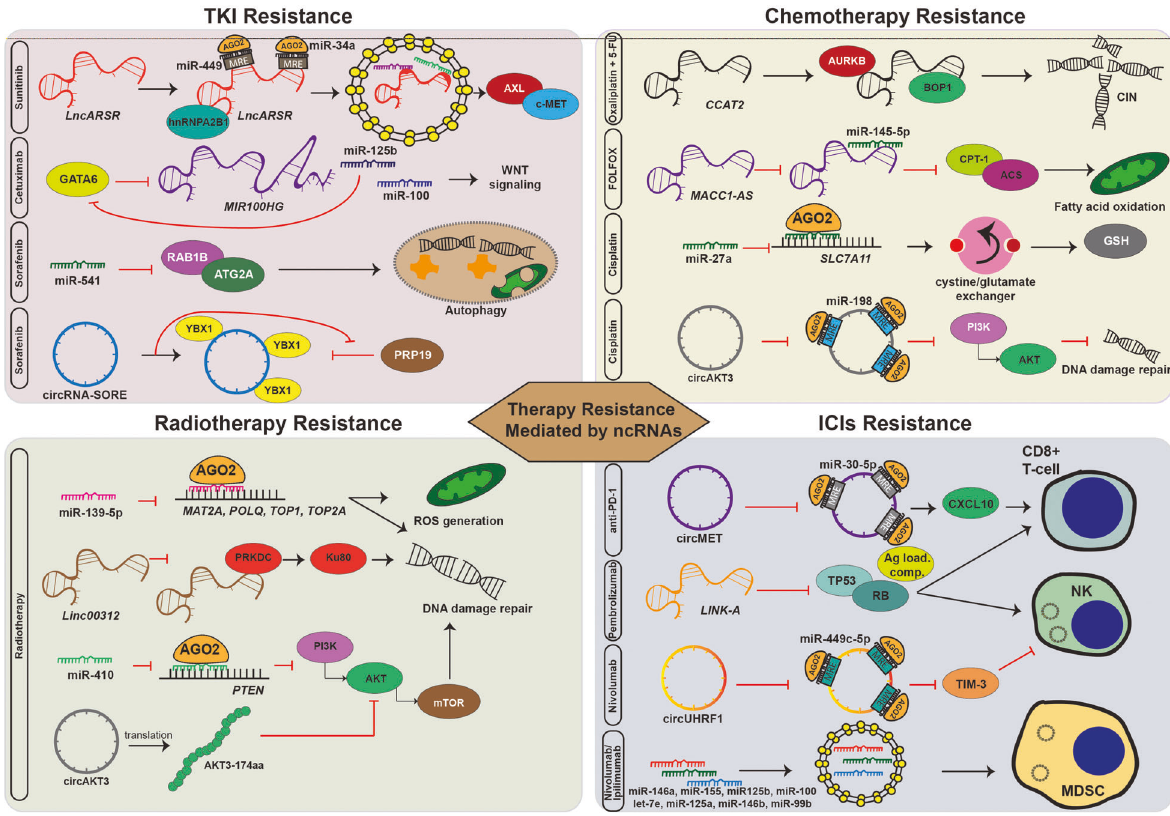
Fig. 2 Mechanisms of therapy resistance mediated by ncRNAs. Examples of the common mechanisms of cancer cell resistance to tyrosine kinase inhibitors, chemotherapy, radiation, and immune checkpoint inhibitors mediated by miRNAs, lncRNAs, or circRNAs. The common mechanisms include (1) modulation of defending intrinsic pathways against the xenobiotics, e.g., miR-27a directly binds to SLC7A11 and decreases the glutathione (GSH), which binds cisplatin and detoxi fi es the intracellular environment, thus a decrease of miR-27a is responsible for cisplatin resistance; (2) promoting survival signaling pathways, e.g., lncARSR , which is packed by hnRNPA2B1 and then binds to miR-34a and miR-449, indirectly upregulates AXL and c-MET to contribute to sunitinib resistance; MIR100HG and its embedded miRNAs, miR-100 and miR- 125b, mediate cetuximab resistance by activating Wnt signaling; circRNA-SORE directly binds to oncogenic protein YBX1 and prolongs its half- life by blocking its transfer into the nucleus, where it is degraded by PRP19 to trigger sorafenib resistance; (3) accelerating DNA damage repair, e.g., miR-410 inhibits the translation of PTEN , leading to the activation of the PI3K/mTOR signaling and accelerating DNA damage repair to induce radiotherapy resistance; circAKT3 inhibits miR-198, which in turn activates the PI3K/AKT signaling and triggers cisplatin resistance; (4) inducing genomic instability, e.g., lncRNA CCAT2 binds with BOP1 and AURKB to induce chromosomal instability (CIN) and resistance to 5- fl urouracil (5-FU) and oxaliplatin; (5) inhibition of cell apoptosis or autophagy, e.g., miR-541 targets Ras-related protein RAB1B and autophagy- related gene 2 A ( ATG2A ), inhibiting autophagy, and further accelerates sorafenib resistance; (6) regulating cell metabolism, e.g., MACC1-AS1 binds and inhibits miR-145-5p, derepressing to key elements (CPT1 and ACS) of the fatty acid oxidation pathway, leading to resistance to the FOLFOX chemotherapy regimen; and (7) tuning the in fi ltrated immune cells, including T cells, myeloid-derived suppressor cells (MDSCs), and natural killer cells in the tumor immune microenvironment, e.g., circMET sponges miR-30-5p and indirectly inhibits the chemotactic